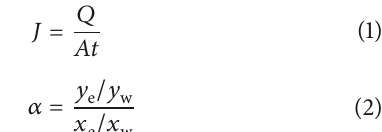
Figure 2: Schematic of the pervaporation